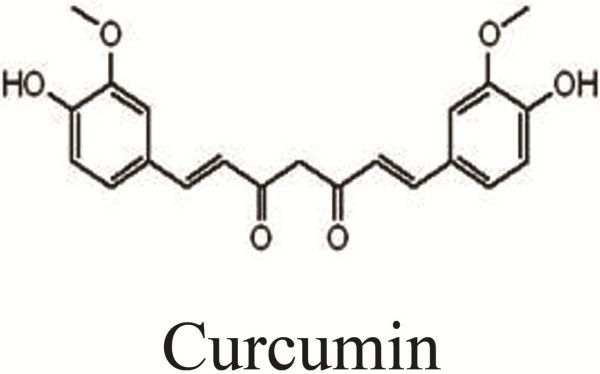
Chemical structure of curcumin. The molecular formula of curcumin is C21H20O6 and its molecular weight is 368.37.